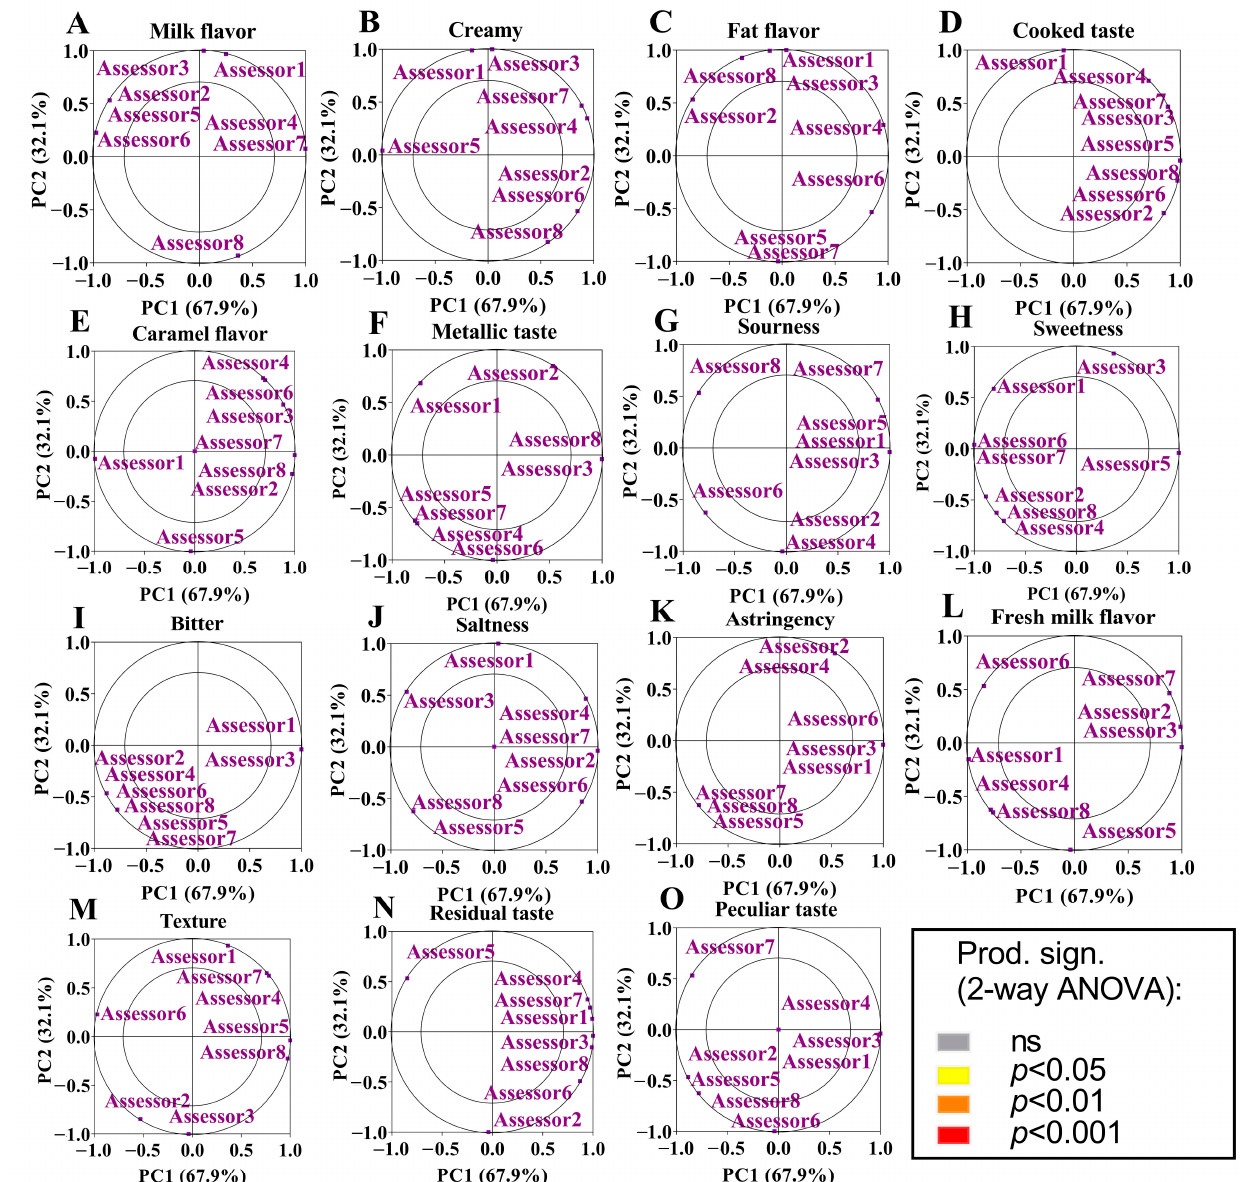
Figure 3. Checking the consistency of sensory evaluation group using Tucker-1 analysis for milk samples stored for 168 h. There were eight assessors and 15 flavors in total. ( A ) Milk flavor; ( B ) Creamy; ( C ) Fat flavor; ( D ) Cooked taste; ( E ) Caramel flavor; ( F ) Metallic taste; ( G ) Sourness; ( H ) Sweetness; ( I ) Bitter; ( J ) Saltness; ( K ) Astringency; ( L ) Fresh milk flavor; ( M ) Texture; ( N ) Residual taste; ( O ) Peculiar taste. A p < 0.05 was considered statistically significant.